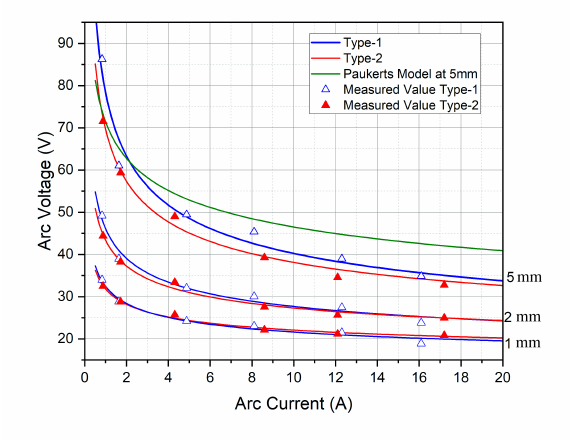
Figure 13. V-I characteristics of proposed